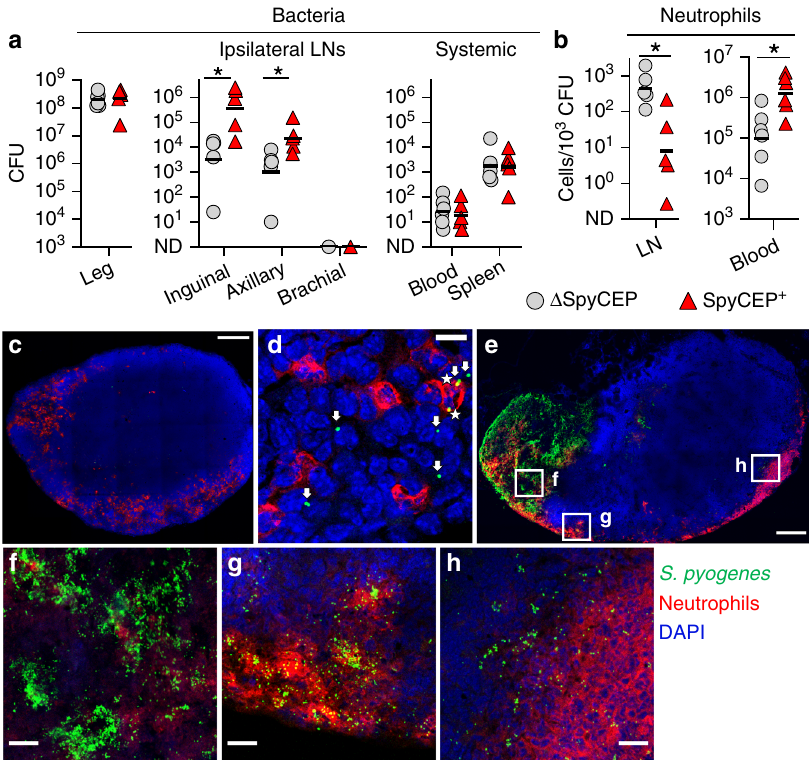
Fig. 5 S. pyogenes subvert recruitment of neutrophils to aid survival within lymph nodes. a , b Recovery of bacteria ( a ) and neutrophil counts (CD45 + , CD11b + , Ly6G + , live singlets) relative to bacterial load ( b ), 3 h after hindlimb intramuscular infection of FVB/n mice with 10 8 CFU of SpyCEP-de fi cient S. pyogenes (grey circles, H1567) or an isogenic SpyCEP + strain (red triangles, H1565). Symbols represent individual mice and black lines indicate geometric means. n = 6 (Leg and Blood) or n = 5 (LNs and Spleen) per group. * p ≤ 0.05; inguinal, p = 0.0180; axillary, p = 0.0440 ( a ); LN, p = 0.0117; blood, p = 0.0120 b two-tailed Student ’ s t -test performed on log 10 -transformed data. c – h Immuno fl uorescence images of cryosections from a draining inguinal lymph node 3 h ( c , d ) or 24 h ( e – h ) after intramuscular infection of FVB/n mice with 10 8 CFU of S. pyogenes H1565 (green); neutrophils (red), and nuclei (blue). Extracellular and intracellular streptococci indicated by arrows and asterisks, respectively ( d ). Scale bars represent 200 µ m ( c , e ) and 20 µ m ( b , f – h ). Imaging data are representative of fi ve independent experiments. See also Supplementary Fig. 5 and Supplementary Movie 9. CFU are per ml of blood, per leg, or per